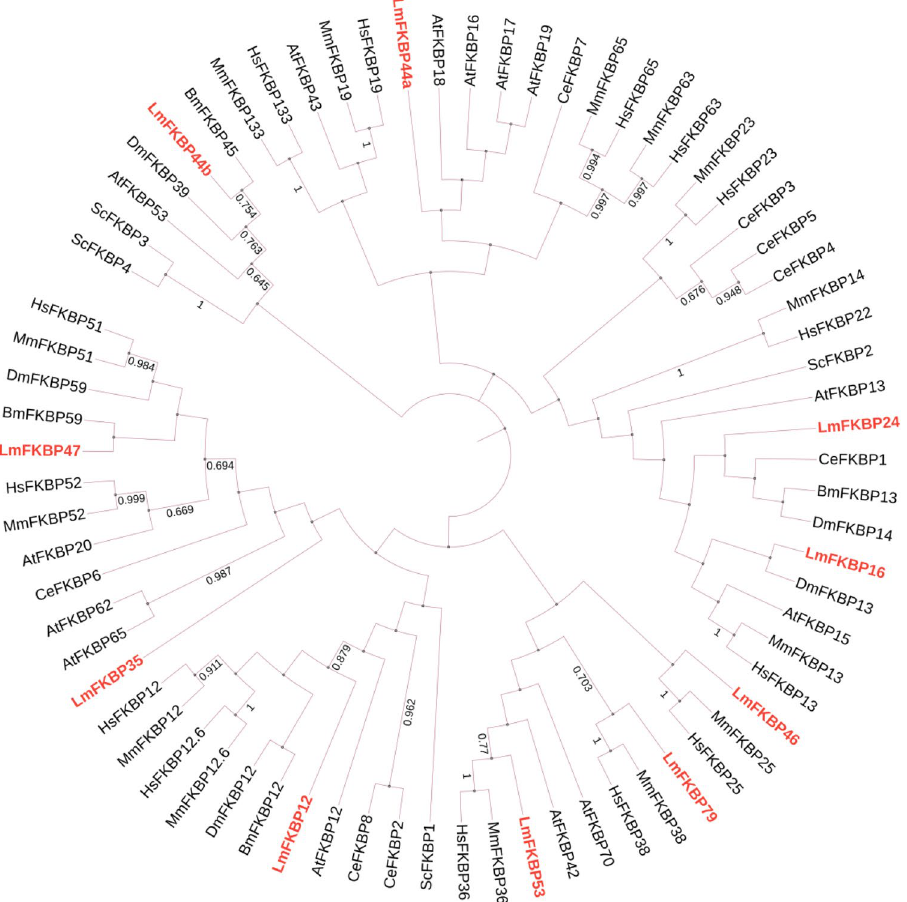
Figure 1. Phylogenetic analysis of FKBPs from Saccharomyces cerevisiae (Se), Homo sapiens (Hs), Arabidopsis thaliana (At), Mus musculus (Mm), Drosophila melanogaster (Dm), Bombyx mori (Bm), Caenorhabditis elegans (Ce), and Locusta migratoria ( Lm ). The UniProt accession numbers of these FKBPs are listed in Table